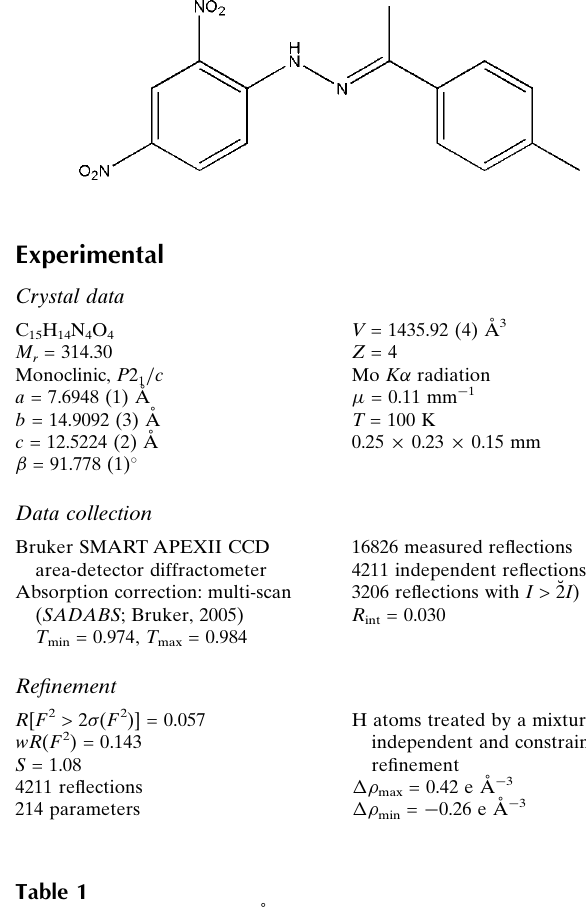
Hydrogen-bond geometry (A˚ , (cid:1) ). D —H (cid:2)(cid:2)(cid:2) A D